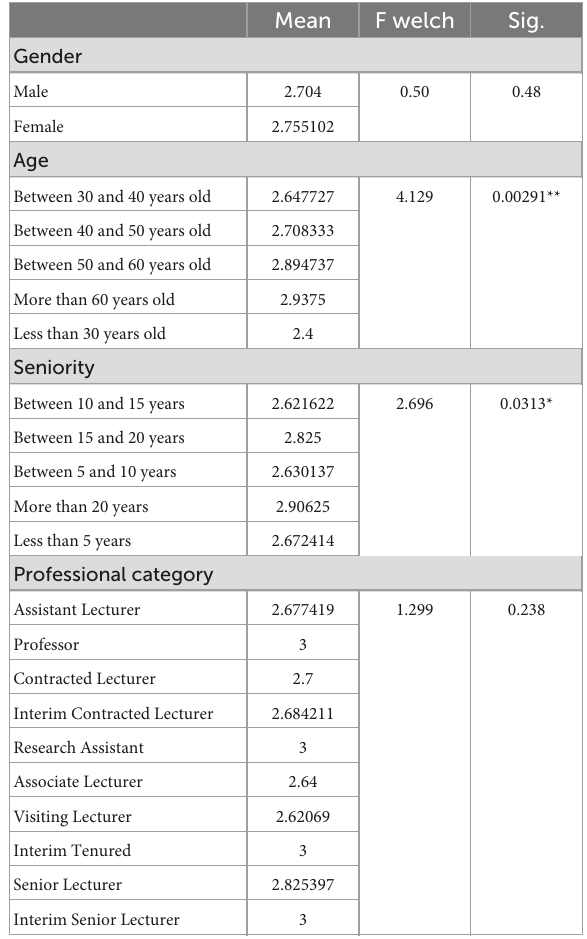
TABLE 1 Distribution of the sample according to gender, age, seniority, and professional category.